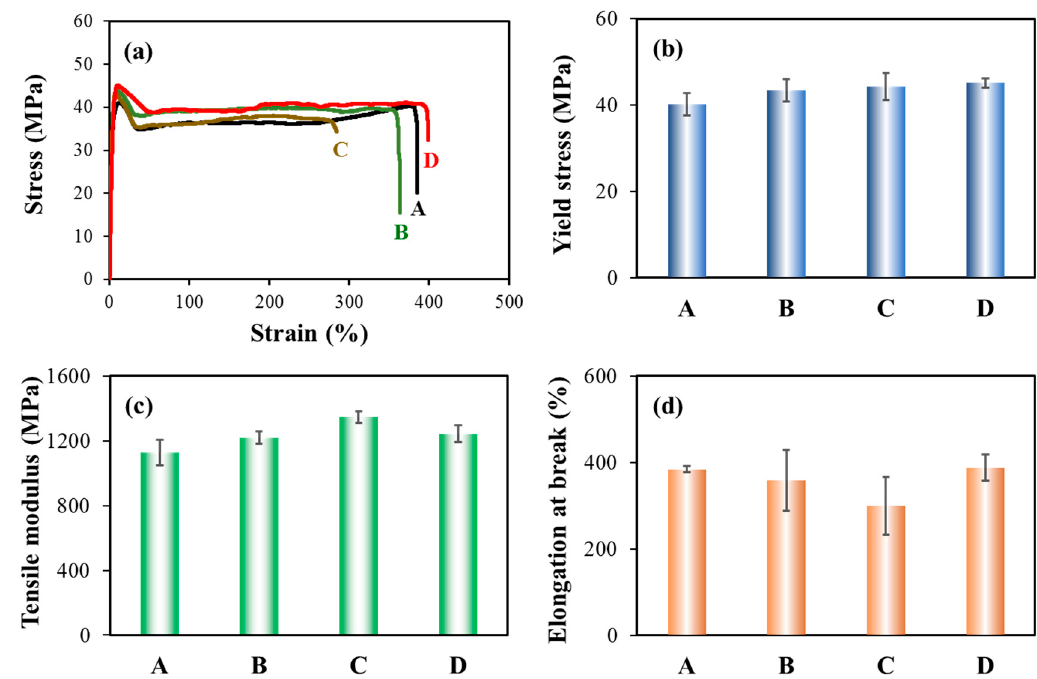
Figure 6. Tensile results of the solid injection-molded parts: ( a ) typical stress–strain curves; ( b ) yield stress; ( c ) tensile modulus; and ( d ) elongation at break of (A) iPP, (B) CNF-0, (C) CNF-0.2 and (D) CNF-0.4 specimens.